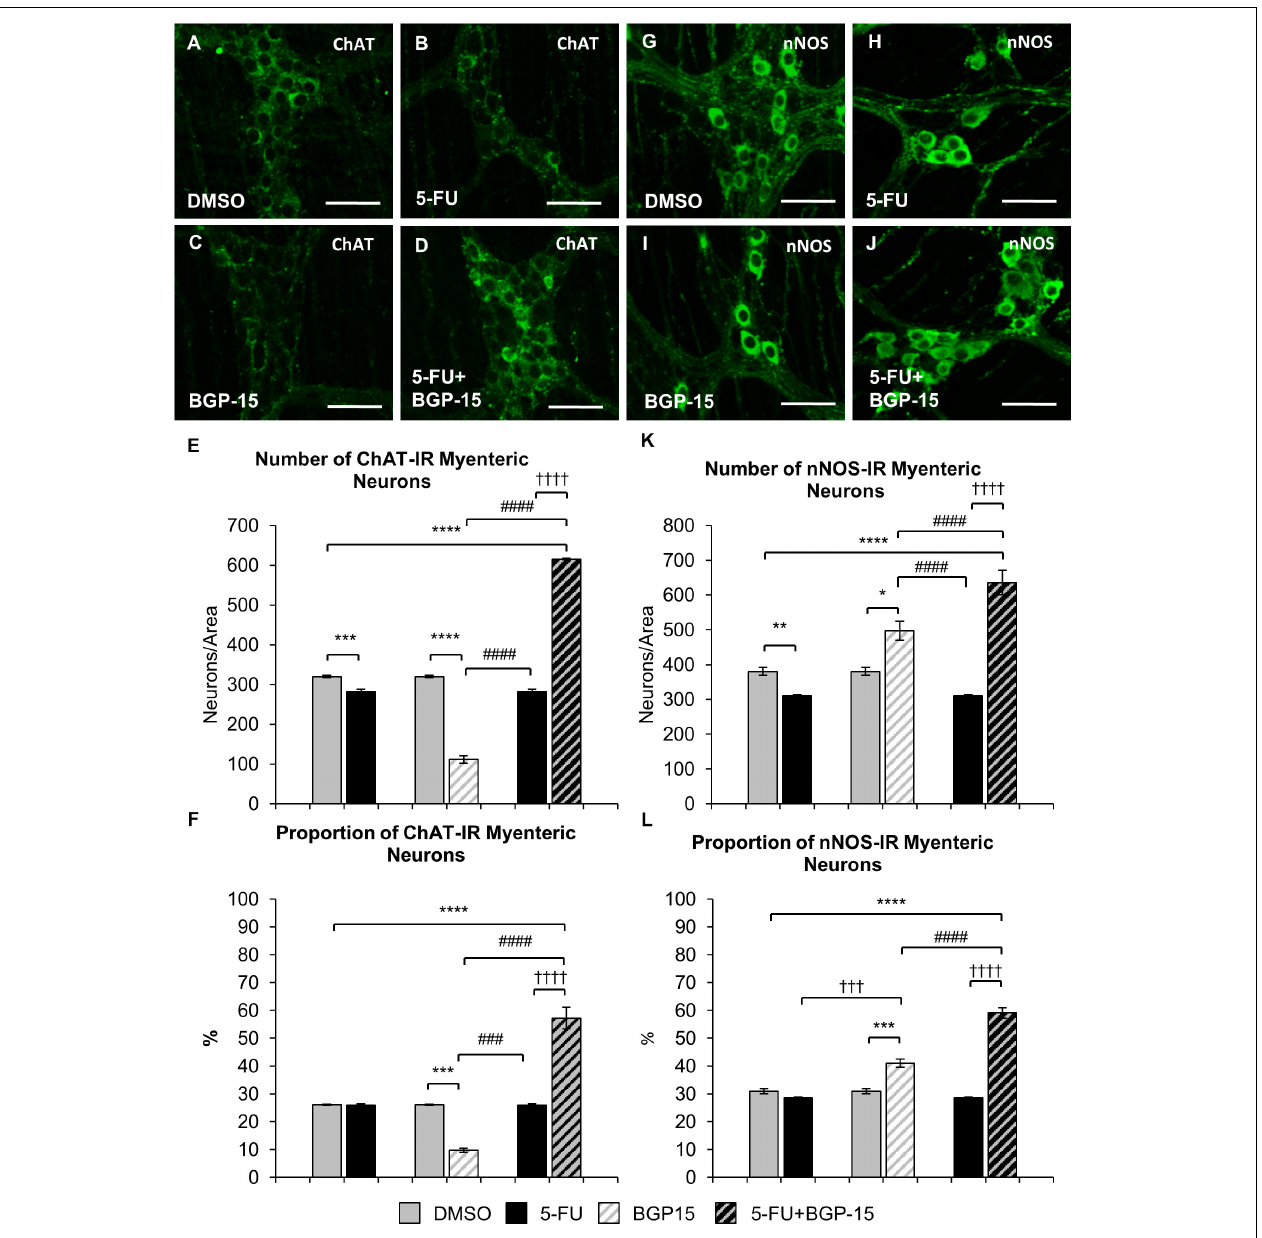
FIGURE 7 | Effect of repeated in vivo 5-FU ± BGP-15 administration on average number and proportion of ChAT and nNOS-IR myenteric neurons. Wholemount preparations of ChAT-IR myenteric neurons (green) in the myenteric plexus of the distal colon in DMSO (A) , 5-FU (B) , BGP-15 (C) , and 5-FU+BGP-15-treated (D) mice, scale bar = 50 µ m. Average number of ChAT-IR neurons in the colon was counted per 2 mm 2 at 14 days in DMSO, 5-FU, BGP-15, and 5-FU+BGP-15-treated mice (E) . Proportion of ChAT-IR neurons to the total number of β Tub III-IR myenteric neurons in the colon was counted at 14 days in DMSO, BGP-15, 5-FU, and 5-FU+BGP-15-treated mice (F) . Wholemount preparations of nNOS-IR neurons (green) in the myenteric plexus of the distal colon in DMSO (G) , 5-FU (H) , BGP-15 (I) , and 5-FU+BGP-15-treated (J) mice, scale bar = 50 µ m. Average number of nNOS-IR neurons in the colon was counted per 2 mm 2 at 14 days in DMSO, 5-FU, BGP-15, and 5-FU+BGP-15-treated mice (K) . Proportion of nNOS-IR neurons to the total number of β Tub III-IR myenteric neurons in the colon was counted at 14 days in DMSO, 5-FU, BGP-15, and 5-FU+BGP-15-treated mice (L) . Data represented as mean ± SEM. ∗ P < 0.05, ∗∗ P < 0.01, ∗∗∗ P < 0.001, ∗∗∗∗ P < 0.0001, significantly different to DMSO group. ††† P < 0.001, †††† P < 0.0001, significantly different to 5-FU group. ### P < 0.001, #### P < 0.0001, significantly different to BGP-15 ( n = 5